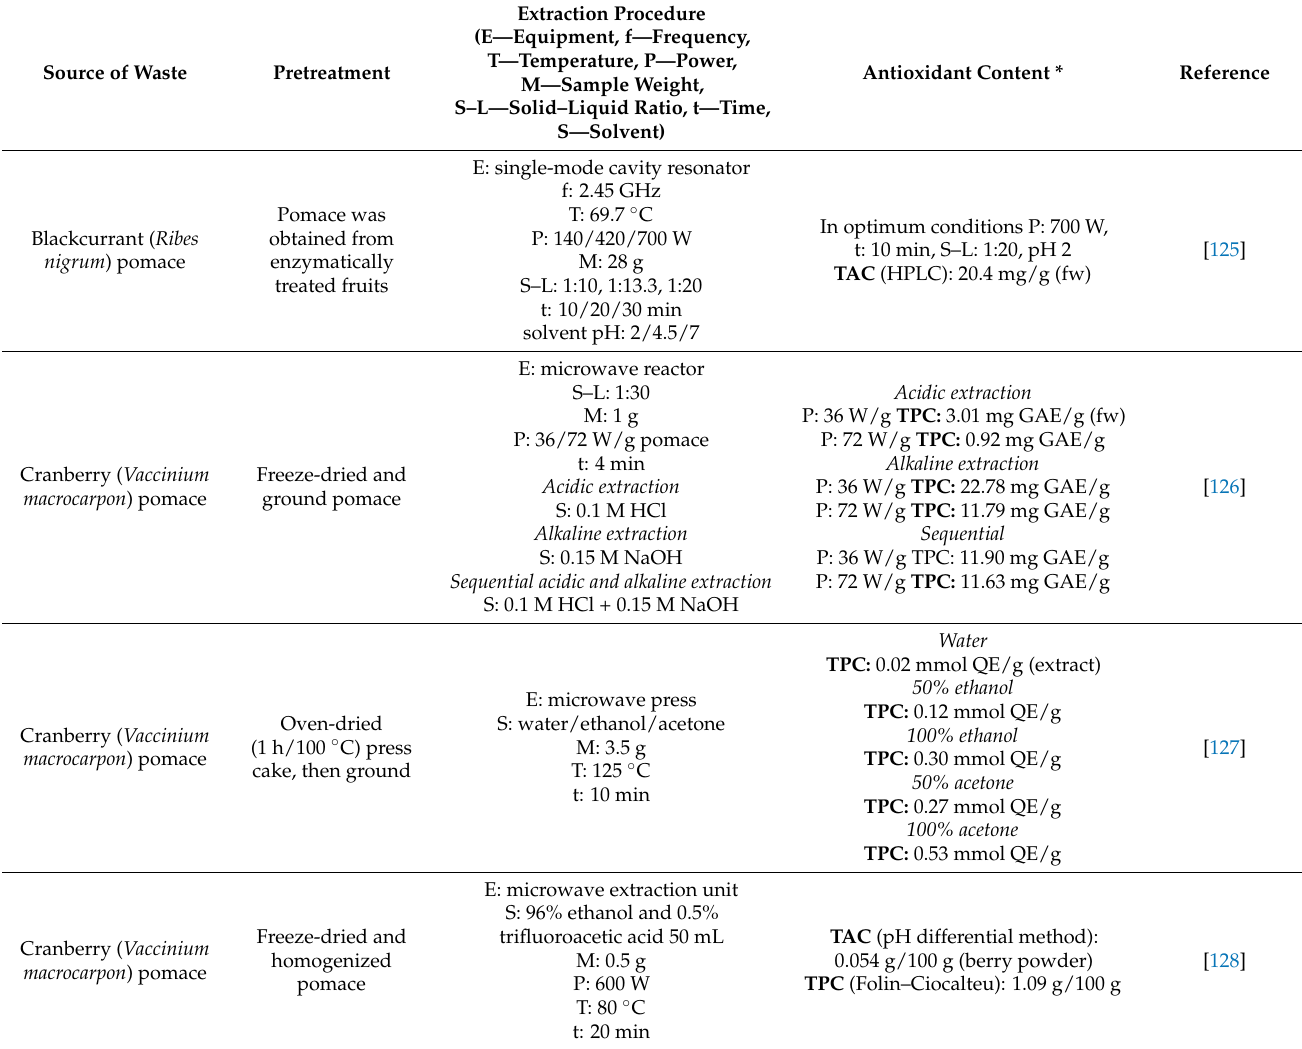
Table 8. Conditions and results of microwave-assisted extraction of bioactive compounds from berry